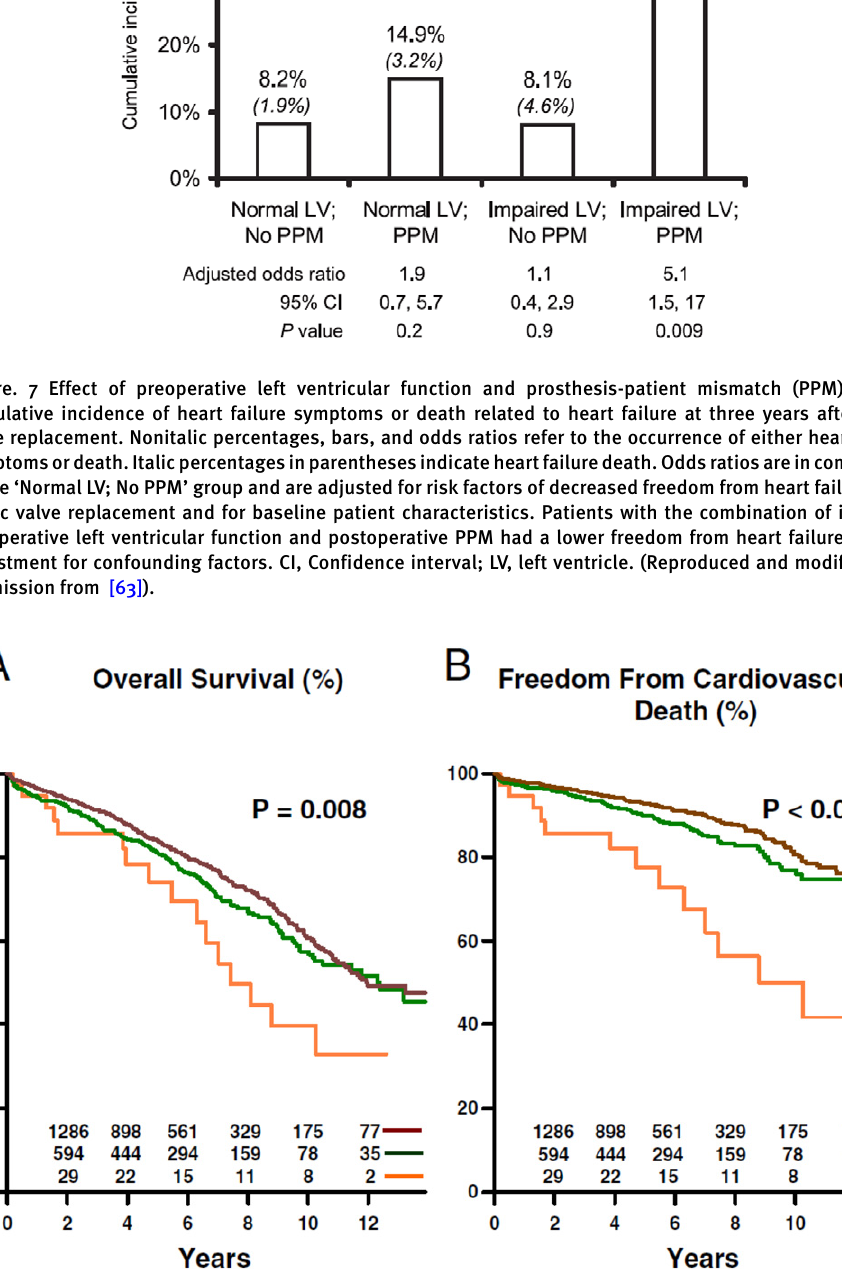
Figure. 8 Late overall survival and freedom from cardiovascular death. Brown line indicates non-significant prosthesis-patient mismatch (PPM); green line indicates moderate PPM; orange line shows severe PPM. (Reproduced and modified with permission from